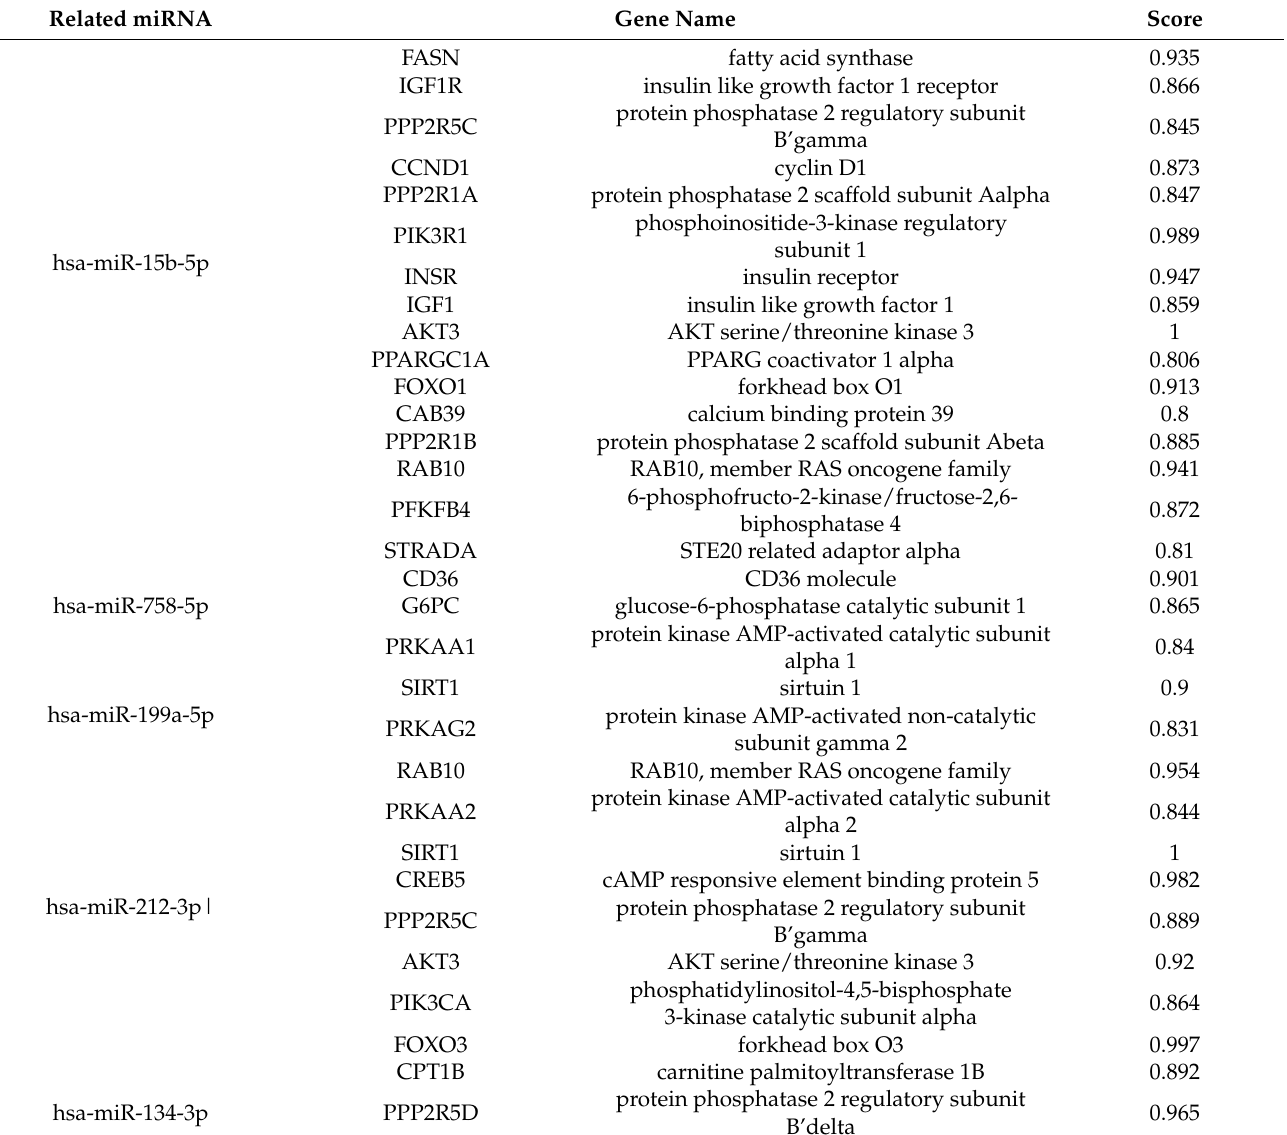
Table 1. The predicted target genes related to the AMPK signaling pathway of the downregulated miRNAs in the cochlear nuclei of noise-exposed